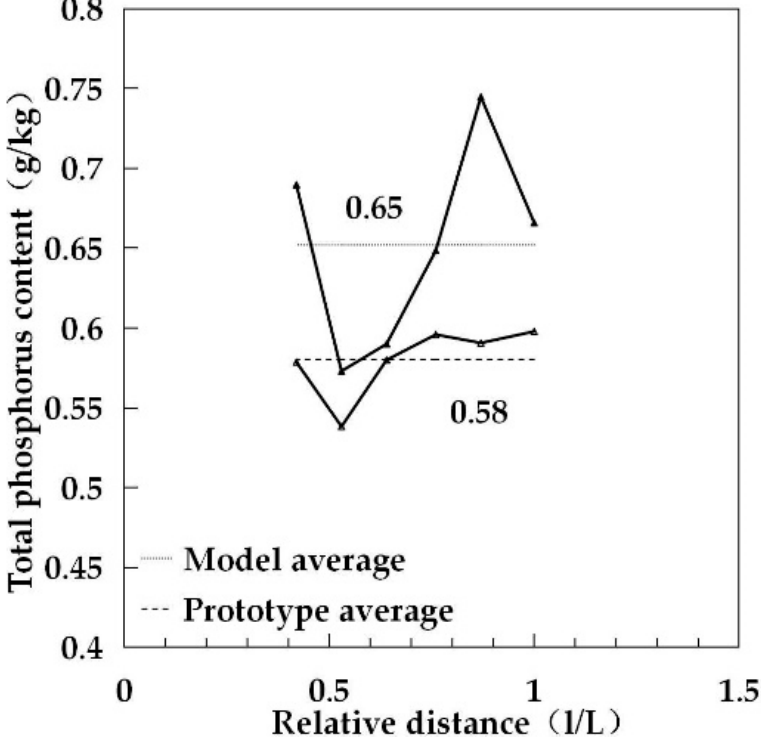
Figure 13. Changes in soil phosphorus content with distance in trenches of the prototype and model.